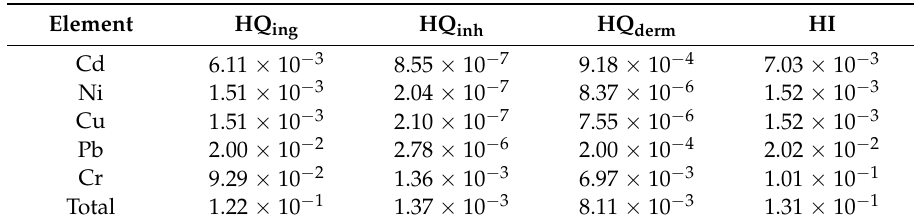
Table 7. Non-carcinogenic exposure risk values (adult) of heavy metal in different exposure pathway in Leisure Squares of Yanta District in